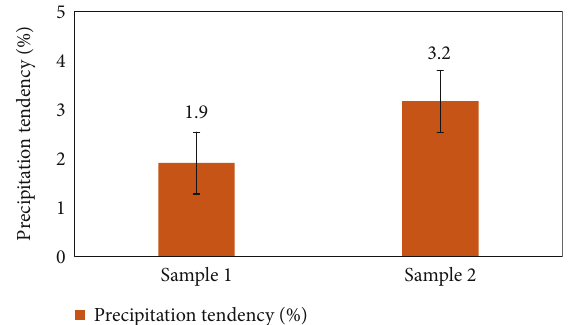
Figure 6: Dissolution e ffi ciency for the developed dissolver versus commercial ones at 35 ° C for 24 hours.